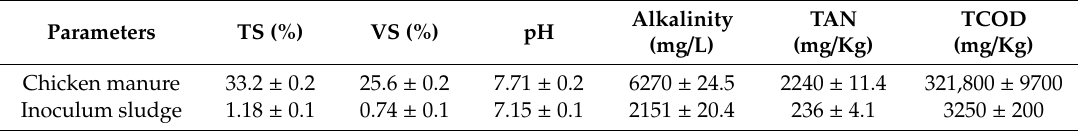
Table 1. Physiochemical characters of the raw chicken manure and inoculum sludge. Parameters TS (%) VS (%) pH Chicken